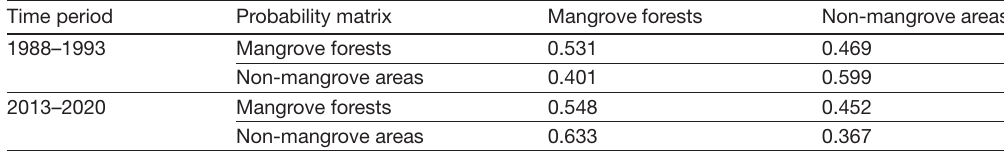
Table A3. Calculated transitional probabilities during 1988–2020